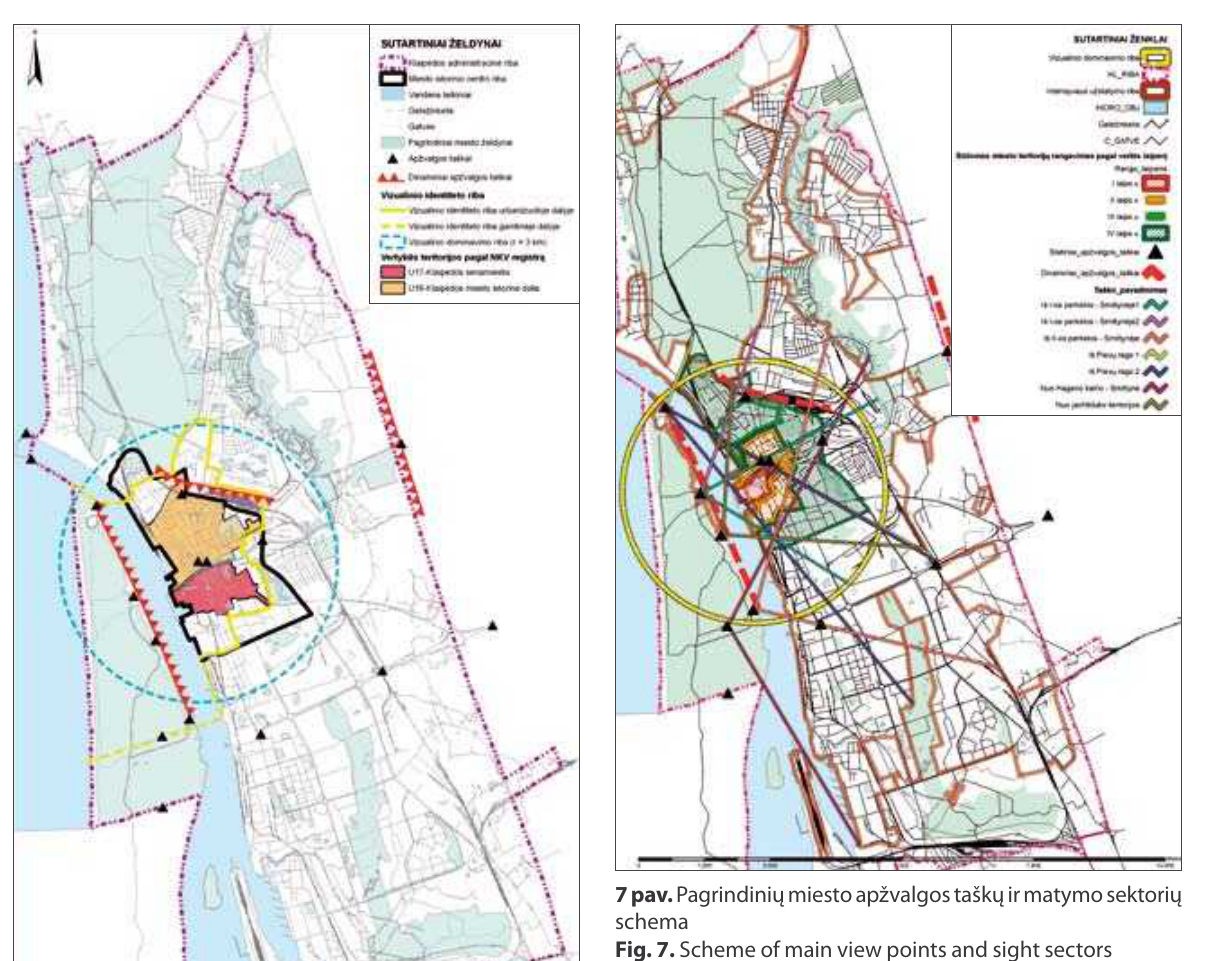
Fig. 7. Scheme of main view points and sight